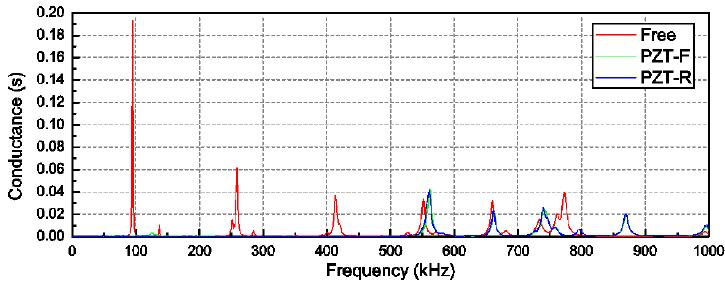
Figure 5. Conductance spectra between the free condition and the interaction condition.